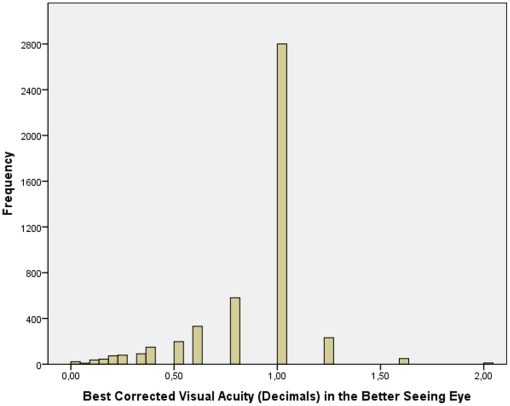
Histogram showing the distribution of best corrected visual acuity in adult Indians in the Central India Eye and Medical Study.